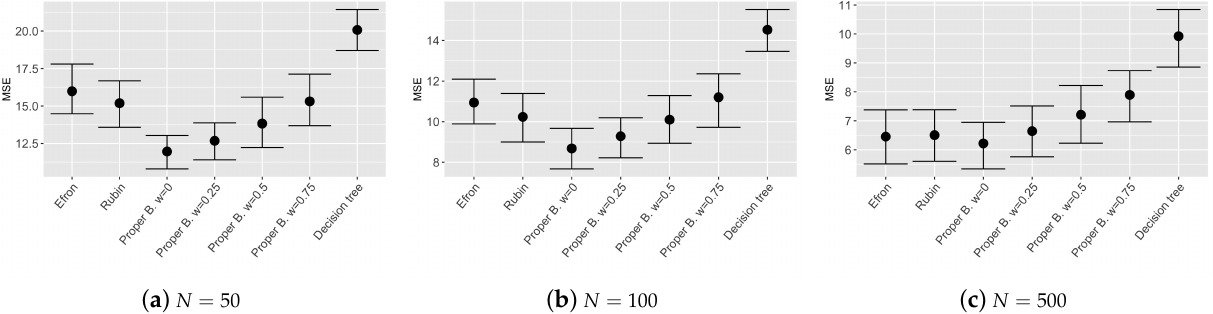
Figure 3. Nonparametric confidence intervals for MSE on the validation set varying N , number of observations in the training set.